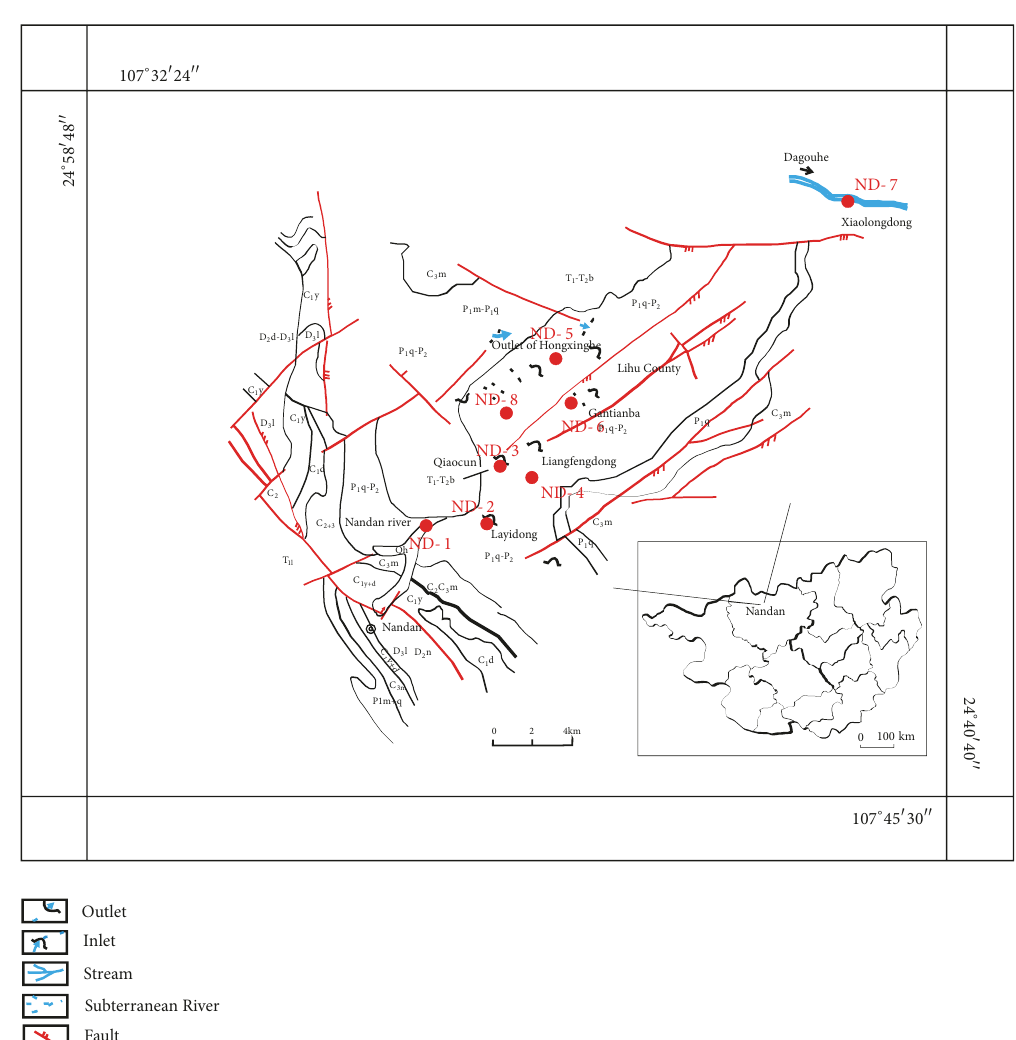
Figure 3: Hydrogeological map and location of sampling sites in the Lihu subterranean river basin